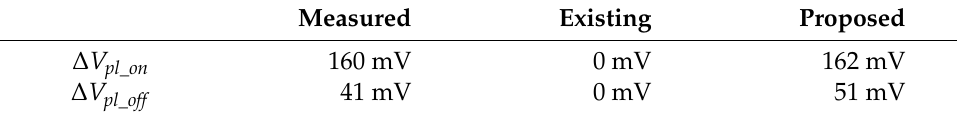
Table 3. Variation of the Miller plateau when C DS _ ext changes from 1 nF to 5 nF. Measured